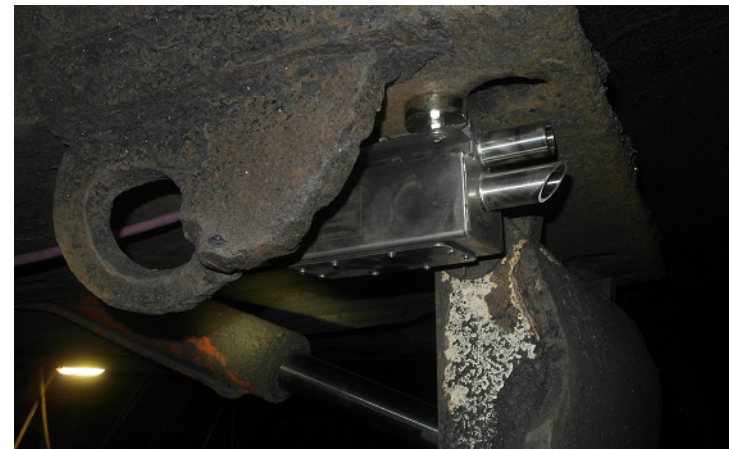
Figure 5. Tip to face distance sensor SSMS-S.